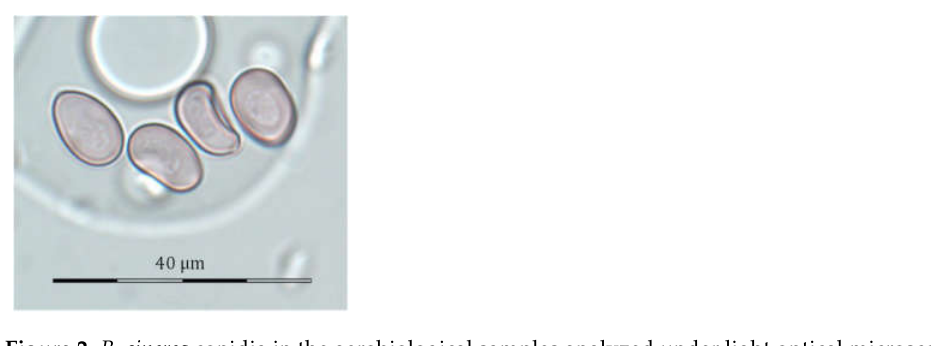
Figure 2. B. cinerea conidia in the aerobiological samples analyzed under light optical microscope at 400× magnification.